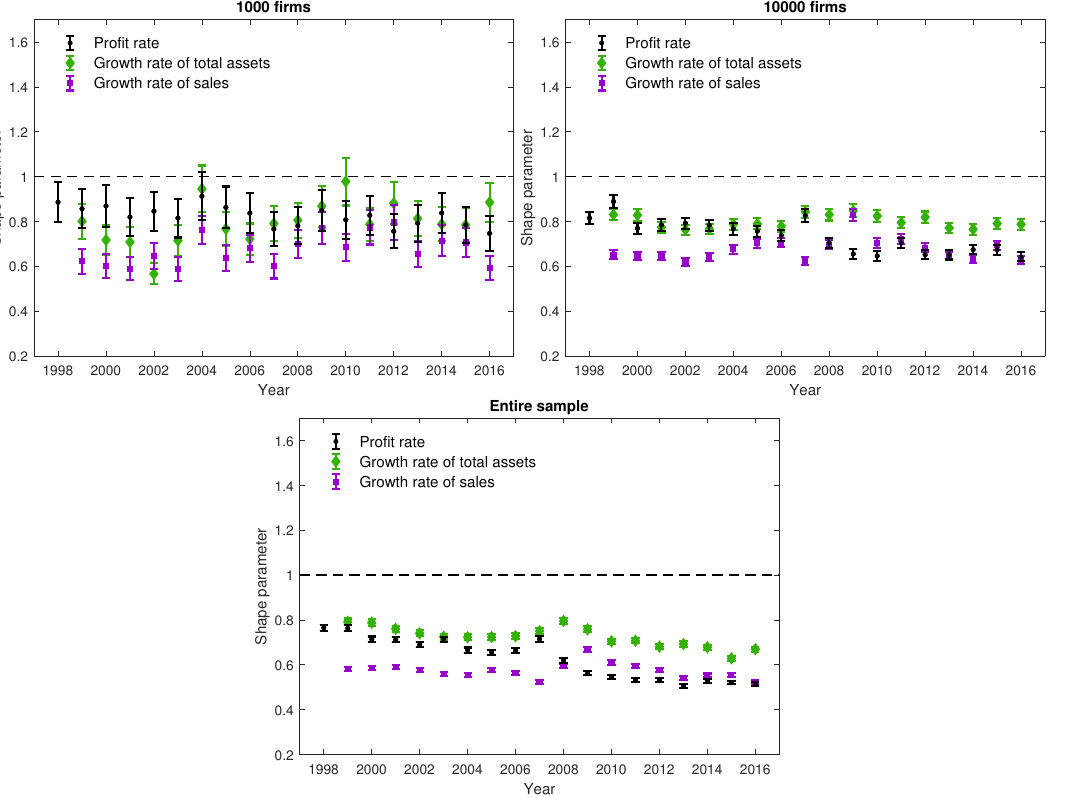
Figure 5. Estimates of the shape parameter of the Subbotin distribution of profit rates, growth of total assets and sales. Error bars show two standard errors. Results refer to the largest long-lived firms of our sample according to their sales in 2016.